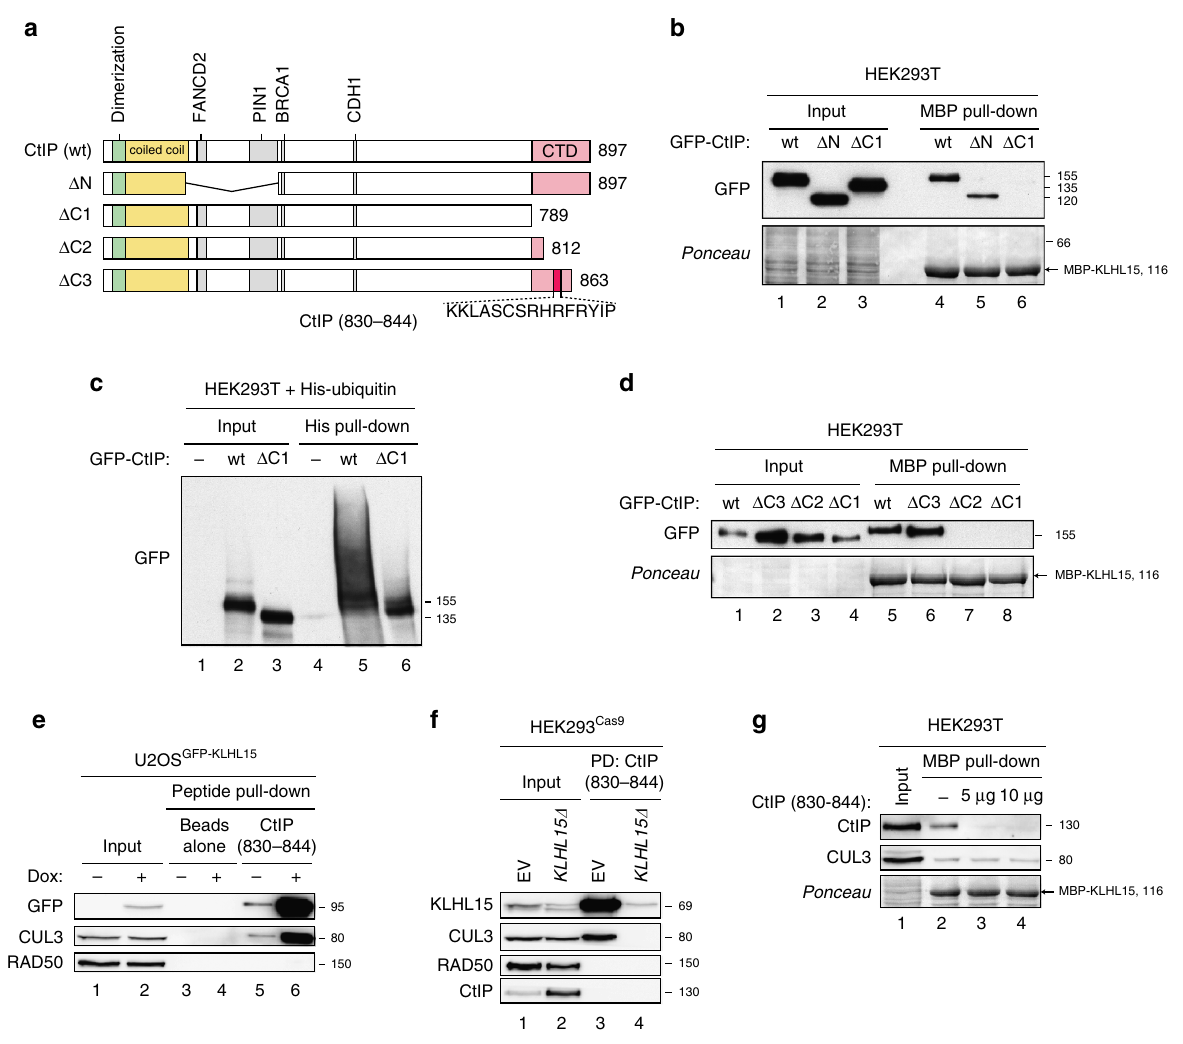
Figure 5 | Mapping of a KLHL15-interacting region in CtIP. ( a ) Schematic representation of GFP-tagged CtIP wild-type (wt) and truncation mutants. A 15-mer peptide encompassing amino acid residues 830–844 in the CtIP CTD important for KLHL15 binding is marked by a red box. ( b ) MBP-KLHL15 was coupled to amylose beads and incubated with lysates of HEK293Tcells transfected with the indicated GFP-CtIP expression constructs for 48h. Inputs and pulled-down protein complexes were analysed by immunoblotting. ( c ) HEK293T cells were cotransfected with the indicated GFP-CtIP expression constructs and His-Ubiquitin. Twenty-four hours post transfection cells were treated with MG-132 (20 m M) for 4h. Cells were then lysed in buffer containing guanidium-HCl and ubiquitin conjugates were pulled-down using Ni-NTA-agarose beads, eluted, and analysed by immunoblotting with anti-GFP antibody. ( d ) MBP-KLHL15 pull-down assays were performed as in b . ( e ) Three microgram of a biotinylated 15-mer CtIP peptide (aa 830–844) indicated in a was coupled to streptavidin beads and incubated with lysates of U2OS GFP-KLHL15-wt cells cultivated in absence ( (cid:2) ) or presence ( þ ) of Dox for 24h. Inputs and pulled-down protein complexes were analysed by immunoblotting. ( f ) Three microgram of the CtIP peptide coupled to streptavidin beads was incubated with lysates of HEK293 Cas9/wt and HEK293 Cas9/ KLHL15 D cells. Inputs and pulled-down protein complexes were analysed by immunoblotting. ( g ) Recombinant MBP-KLHL15 was coupled to amylose beads and incubated with lysates of HEK293Tcells in the absence ( (cid:2) ) or presence of the indicated amounts of the CtIP 15-mer peptide. Inputs and pulled-down protein complexes were analysed by